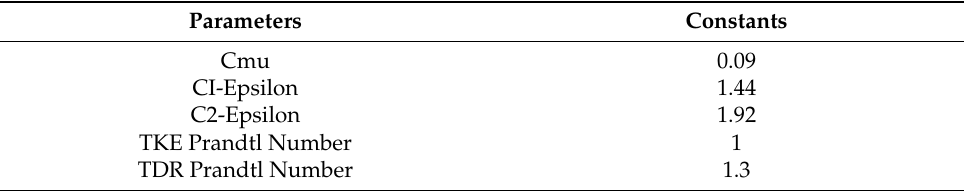
Table 2. Parameters for the constants used in k-epsilon Model.